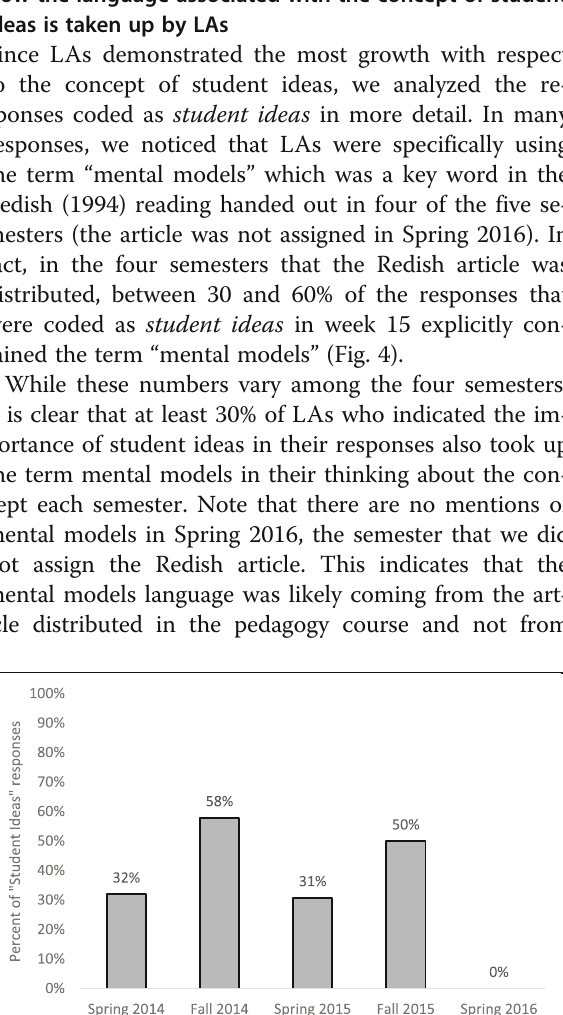
Fig. 5 Student ideas codes by semester. Percentage of responses coded as student ideas in week 2 (solid gray bars) versus week 15 (patterned bars) from Spring 2014 through Spring 2016. These responses include both LAs ’ definitions of teaching and